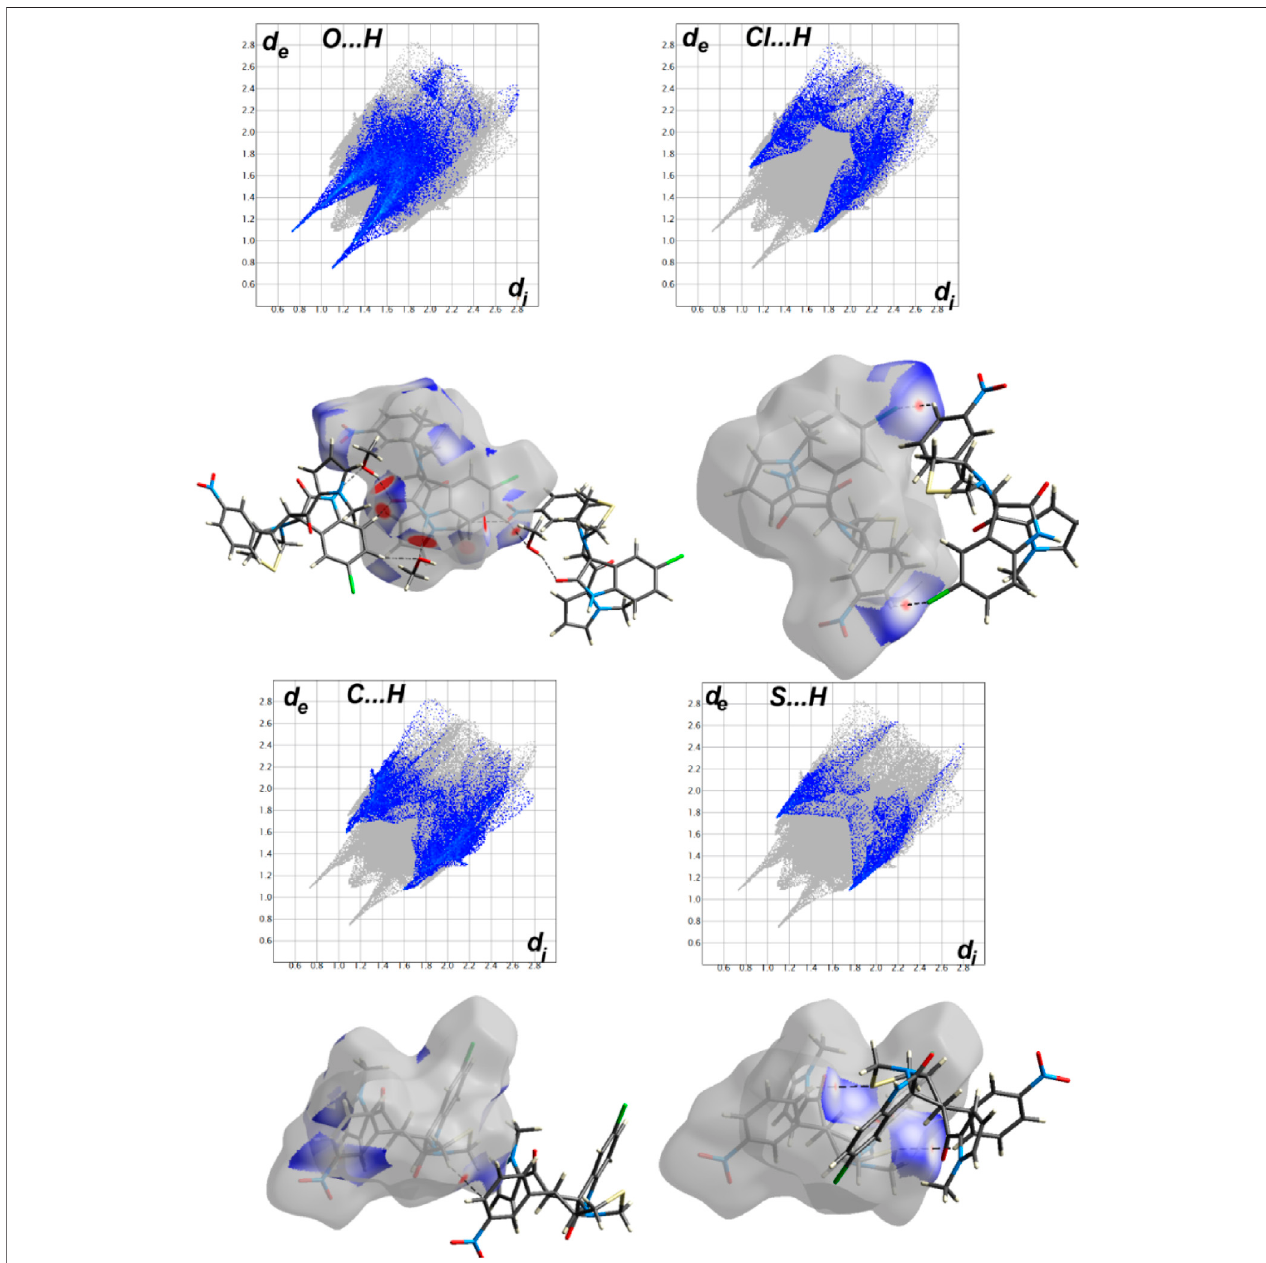
FIGURE 5 | Hirshfeld analysis of 2b